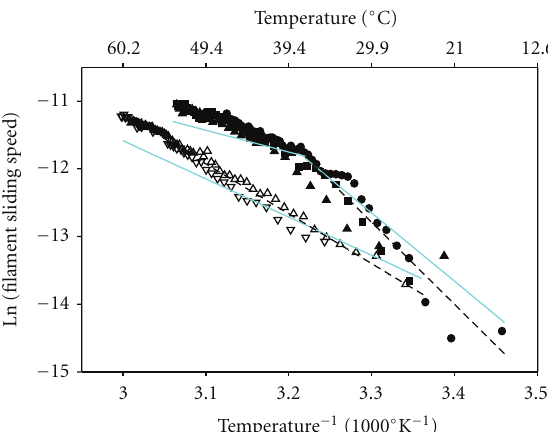
Figure 3: Correction for temperature-dependent e ff ects of solvent viscosity (solid, cyan lines) on filament sliding speed of regulated thin filaments (solid symbols) and unregulated F-actin (open symbols). Data from Figure 1(c) were replotted in Arrhenius form (symbols as in Figure 1), with data omitted for regulated thin filaments above ∼ 54 ◦ C and filament sliding speeds expressed in μ m s − 1 . Dashed lines (black) are linear least squares regressions on the data before correction for temperature-dependent changes in solvent viscosity. Note the change in slope at ∼ 38 ◦ C ( T t ) for regulated thin filaments. E ff ects of temperature-dependent changes in solvent viscosity (normalized to that at body temperature, 37 ◦ C) were removed by assuming that speed varies inversely with viscosity, as demonstrated experimentally [43]; the net result of this correction in all instances is a decrease in apparent E a